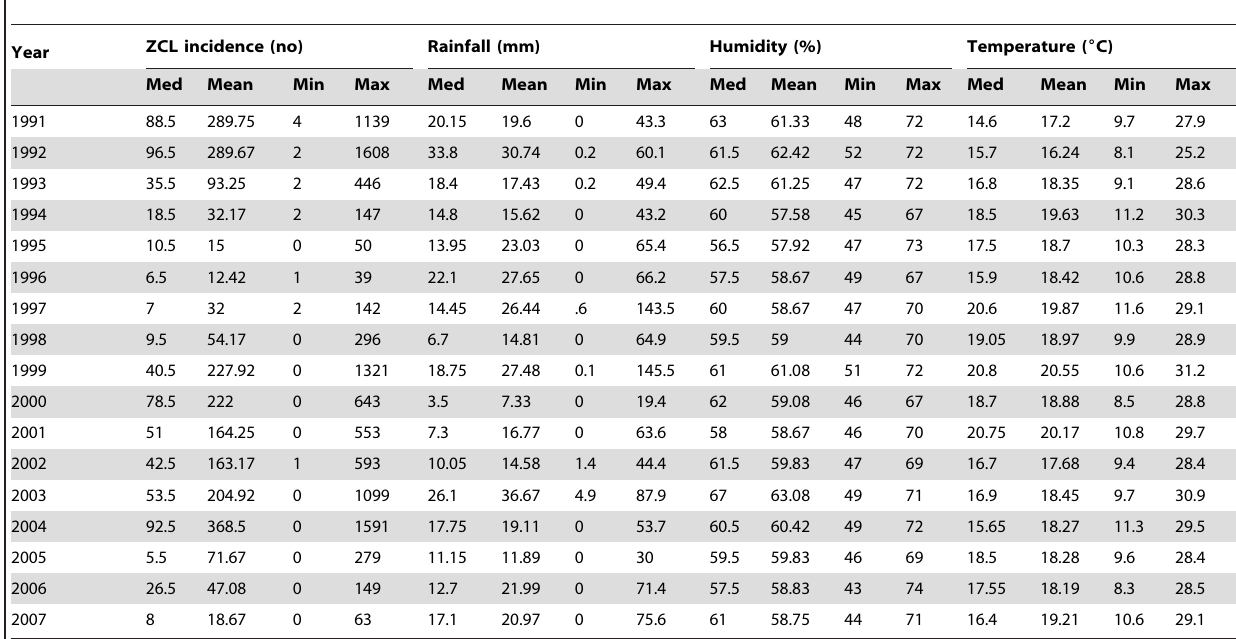
Table 1. Yearly descriptive statistics of ZCL incidence, rainfall humidity and temperature during the study period.